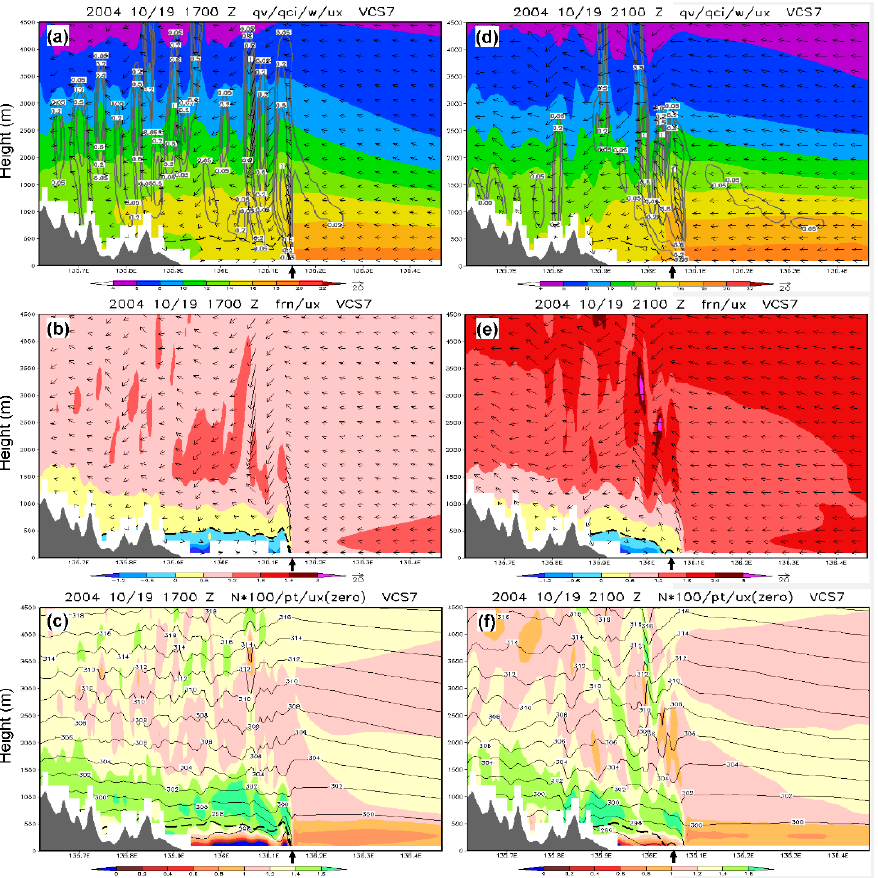
Figure 11. Model-simulated images as in Figure 10, except along VCS7 and at ( a – c ) 1700 and ( d – f ) 2100 UTC, 19 October 2004.